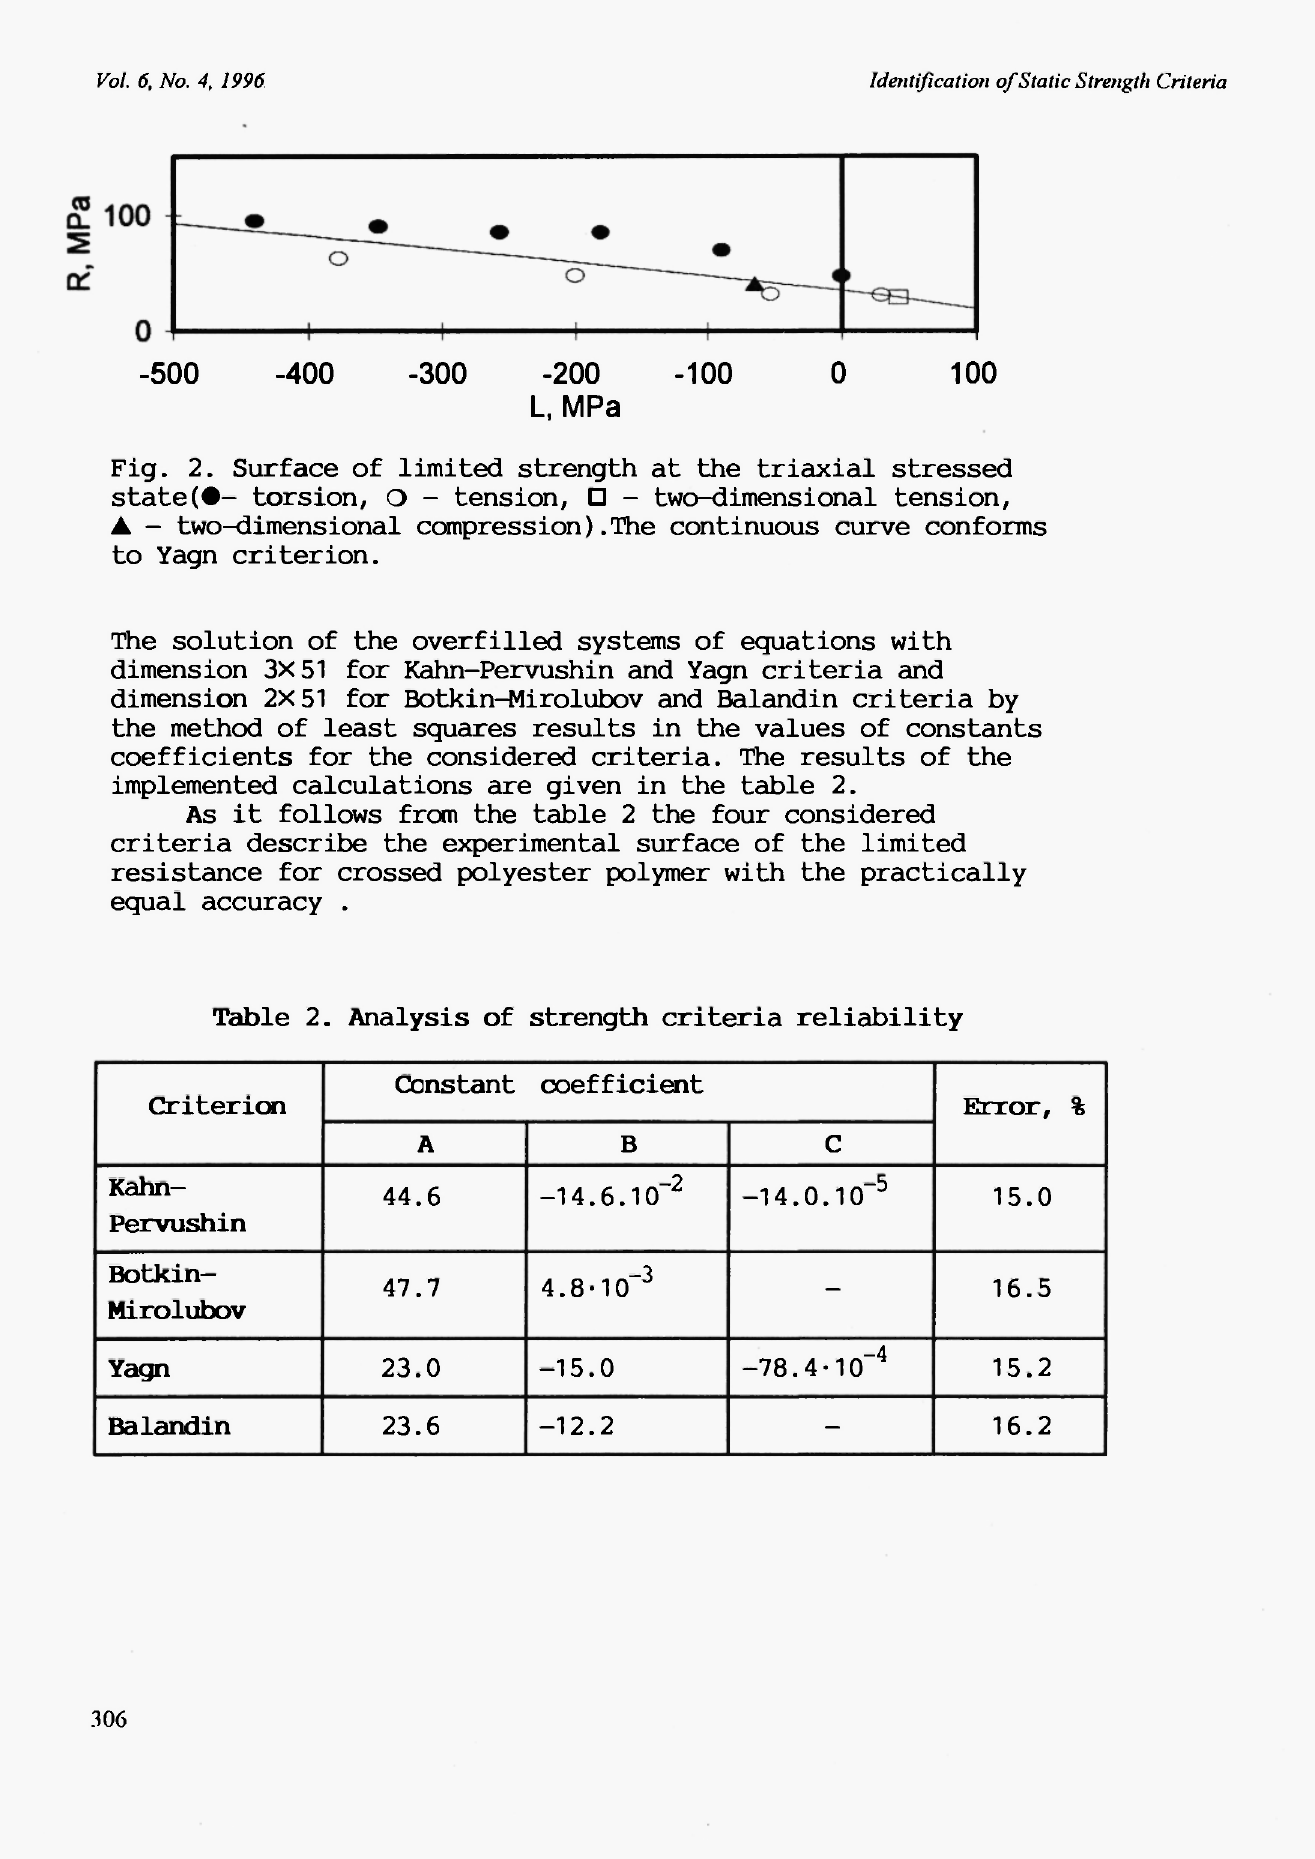
Fig. 2. Surface of limited strength at the triaxial stressed